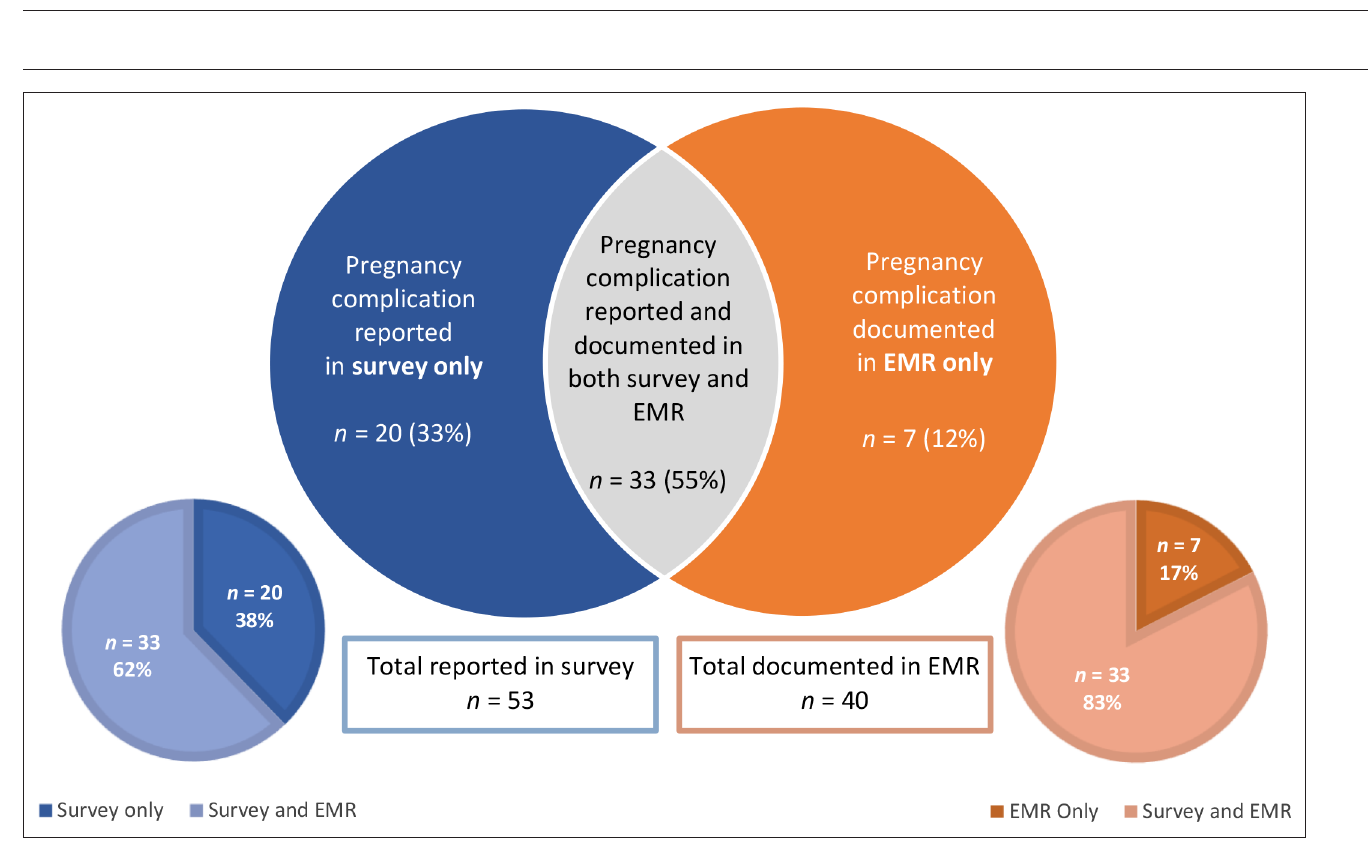
Figure 3 Diagram indicating whether the pregnancy complication was reported in the survey and/or EMR (electronic medical record) of all responders who had a pregnancy complication and consented to chart review ( n =